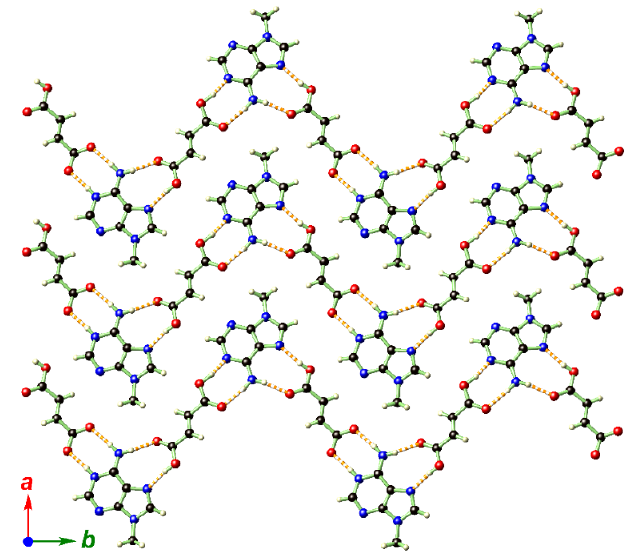
Figure 5. The hydrogen-bonded network layer in 2 extended within the ab plane and exclusively supported by the adenine moiety in TAF and fumarate. Color codes: O (red), N (blue), C (black), H (light-yellow).